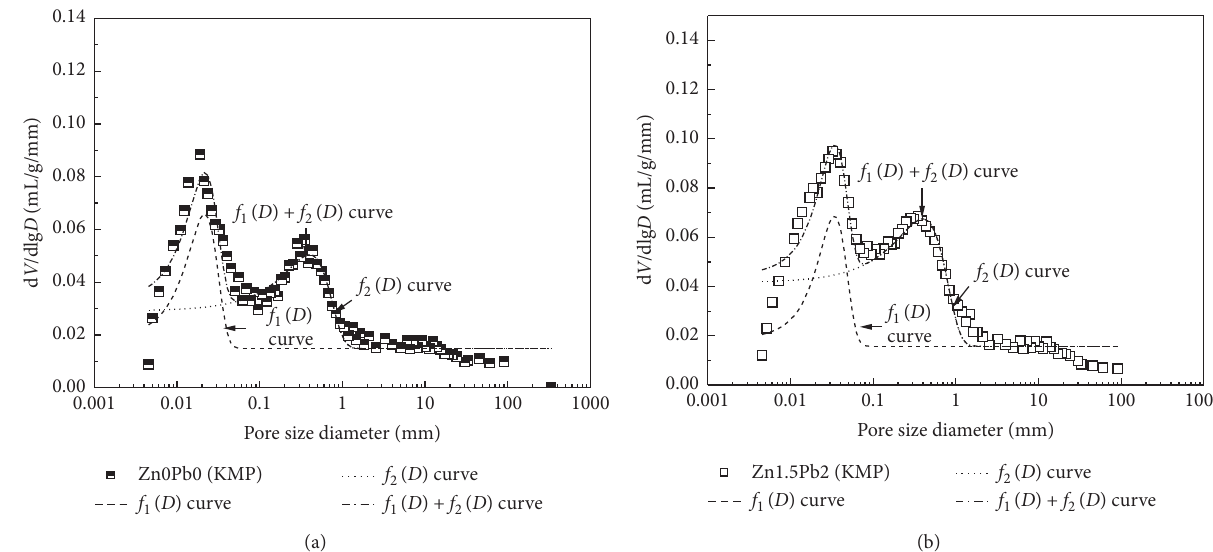
Figure 9: Bimodal PSD peak fitting for the KMP stabilized soils cured for 28d: (a) Zn0Pb0 and (b) Zn1.5Pb2.